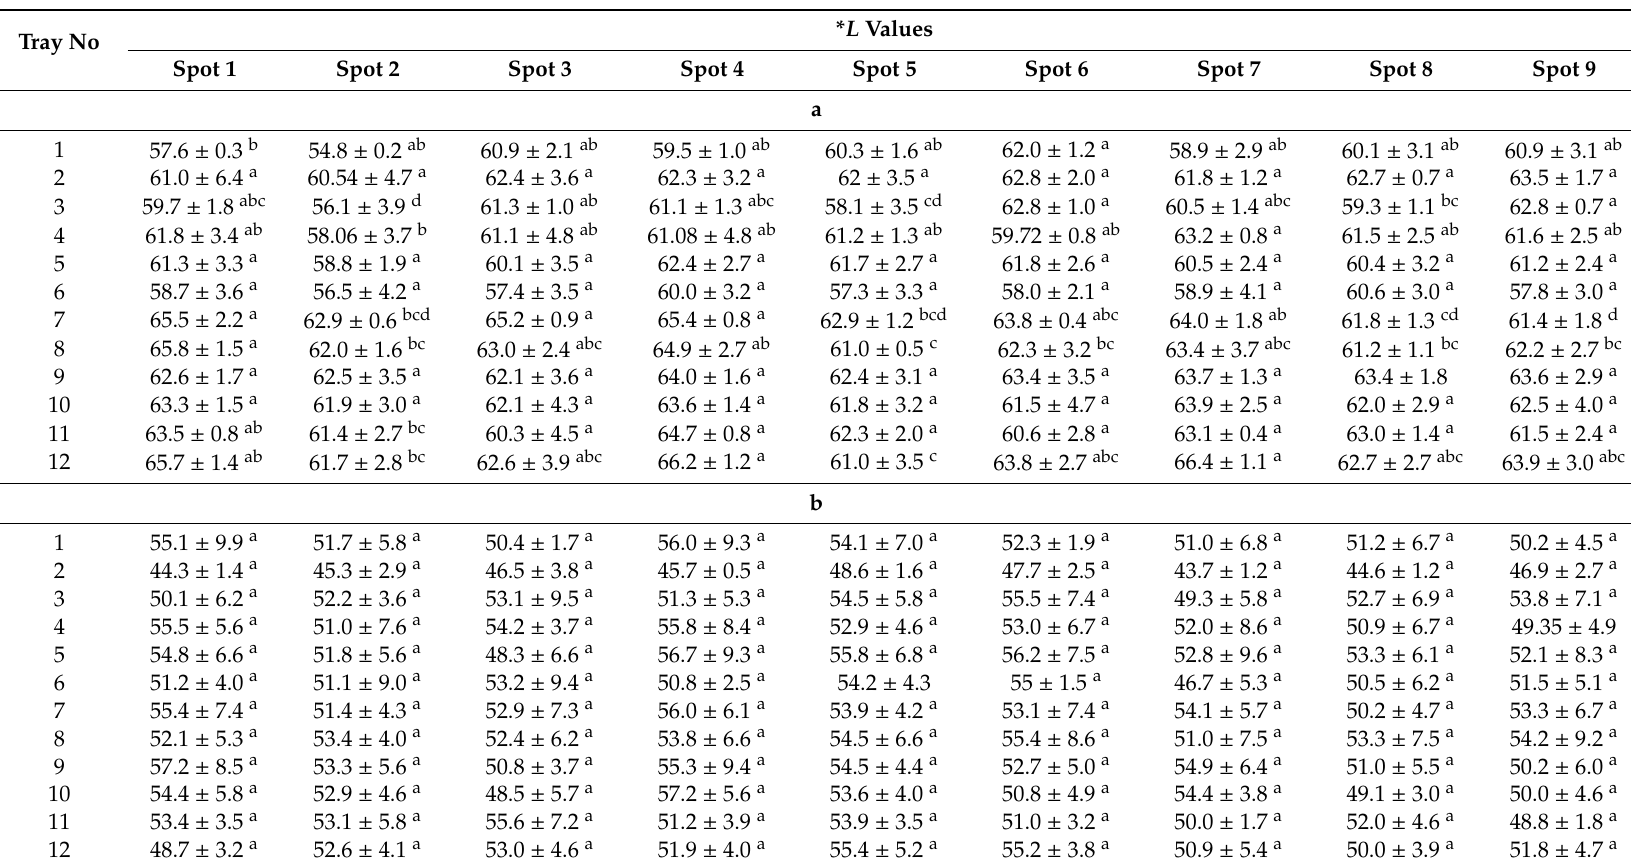
Table 3. a: Lightness (* L ) values on 9 spots of each processing tray when processed using R-65; b: Lightness (* L ) values on 9 spots of each processing tray when processed using